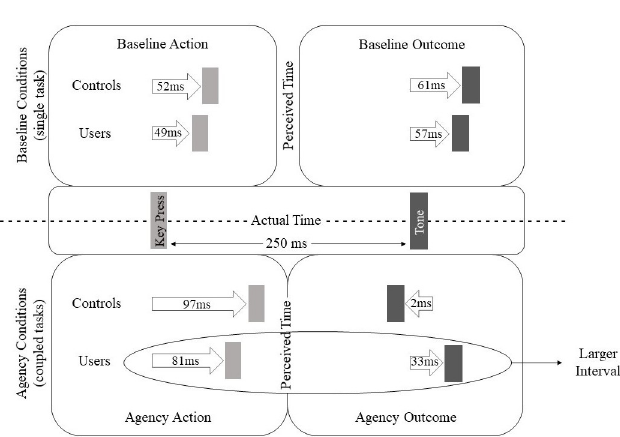
Fig 2. Intentional binding of drug users versus controls. Illustrated are shifts in perception (difference = actual time minus perceived time) for baseline action (1), baseline outcome (2), agency action (3), and agency outcome (4). Key press = action, tone = event. Drug users = consumption beyond